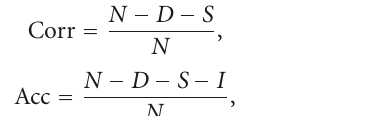
Figure 2: Automaton expression of the grammar. Table 1: Experimental conditions.